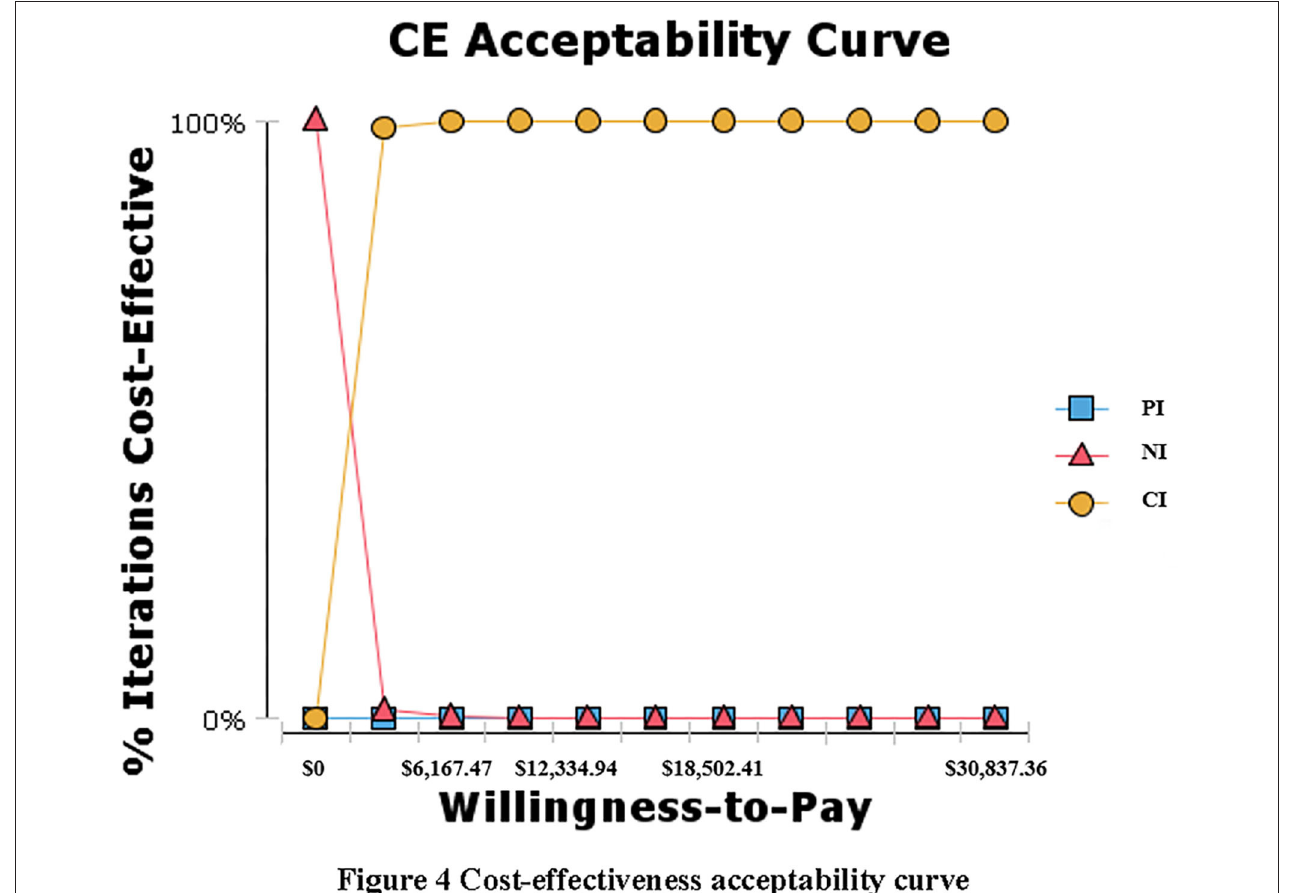
FIGURE 4 | Cost-effectiveness acceptability